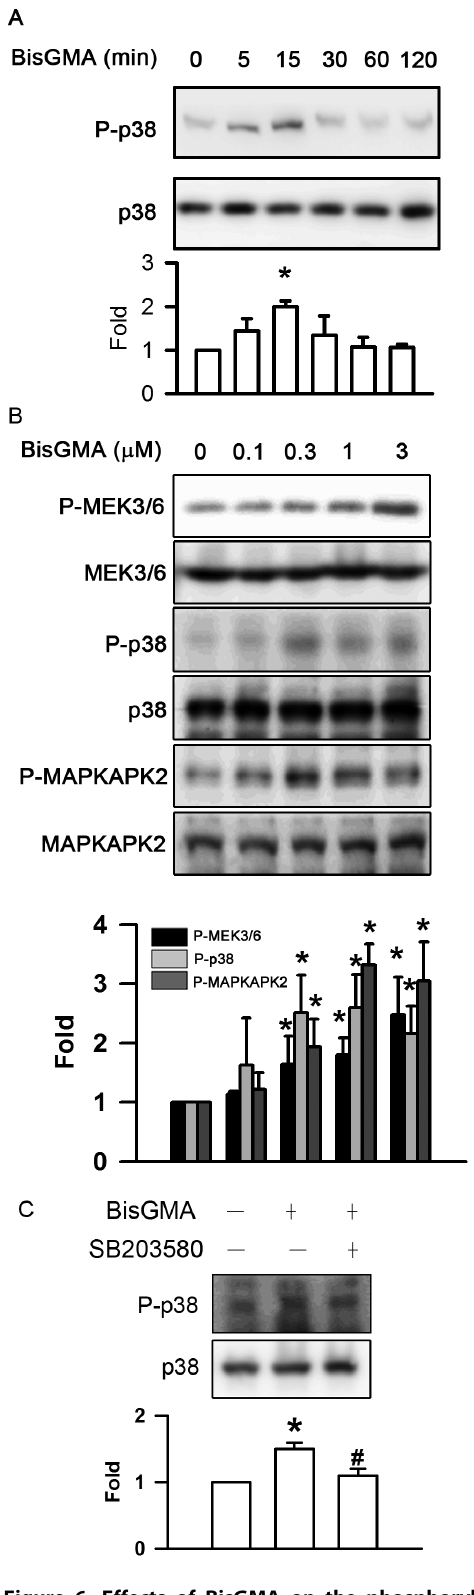
Figure 6. Effects of BisGMA on the phosphorylation of p38 pathway. (A) RAW264.7 macrophages were stimulated with 3 m M BisGMA for the indicated treatment periods. Cells were harvested and protein extracts were subjected to SDS-PAGE. Western blot analysis